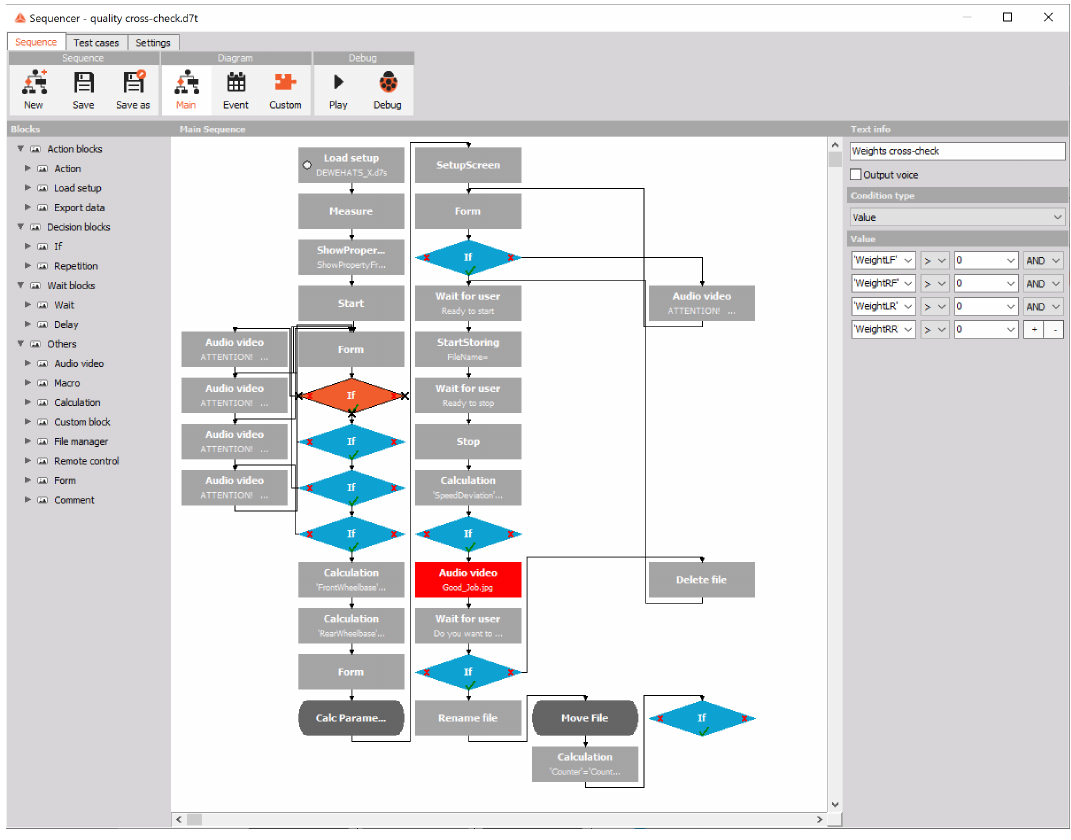
Figure 1. The DEWESoft’s modeling